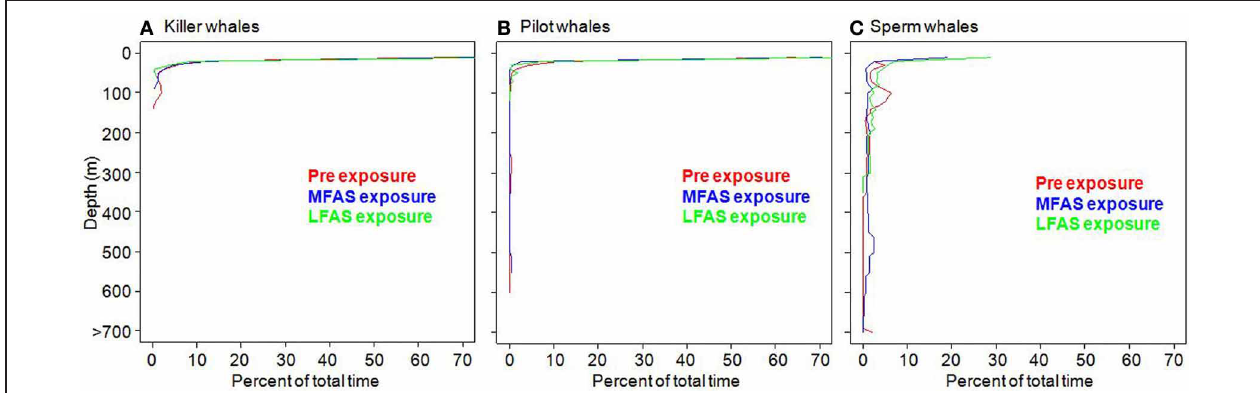
FIGURE 1 | Percent of total time spent at different depths in the water column during the different experimental conditions (LFAS, MFAS, PRE) for (A) killer whales, (B) long-finned pilot whales and (C) sperm whales.